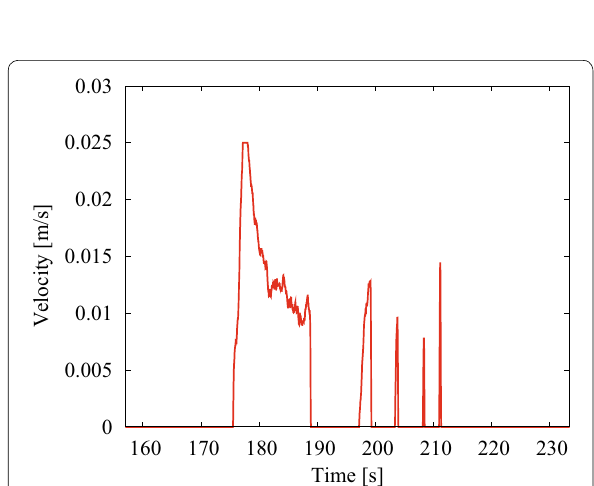
Fig. 15 Reference velocity of slave arm (x-axis) (in HILS 2)